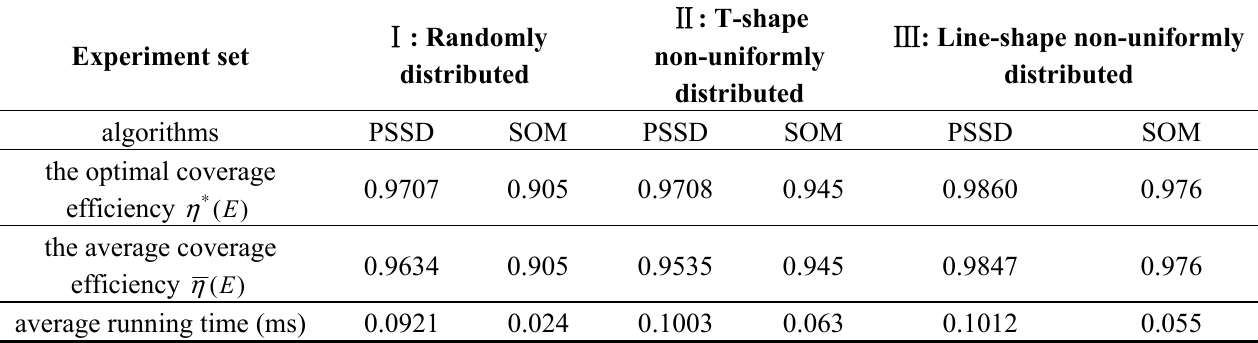
Table 2. Summary of Results in Static